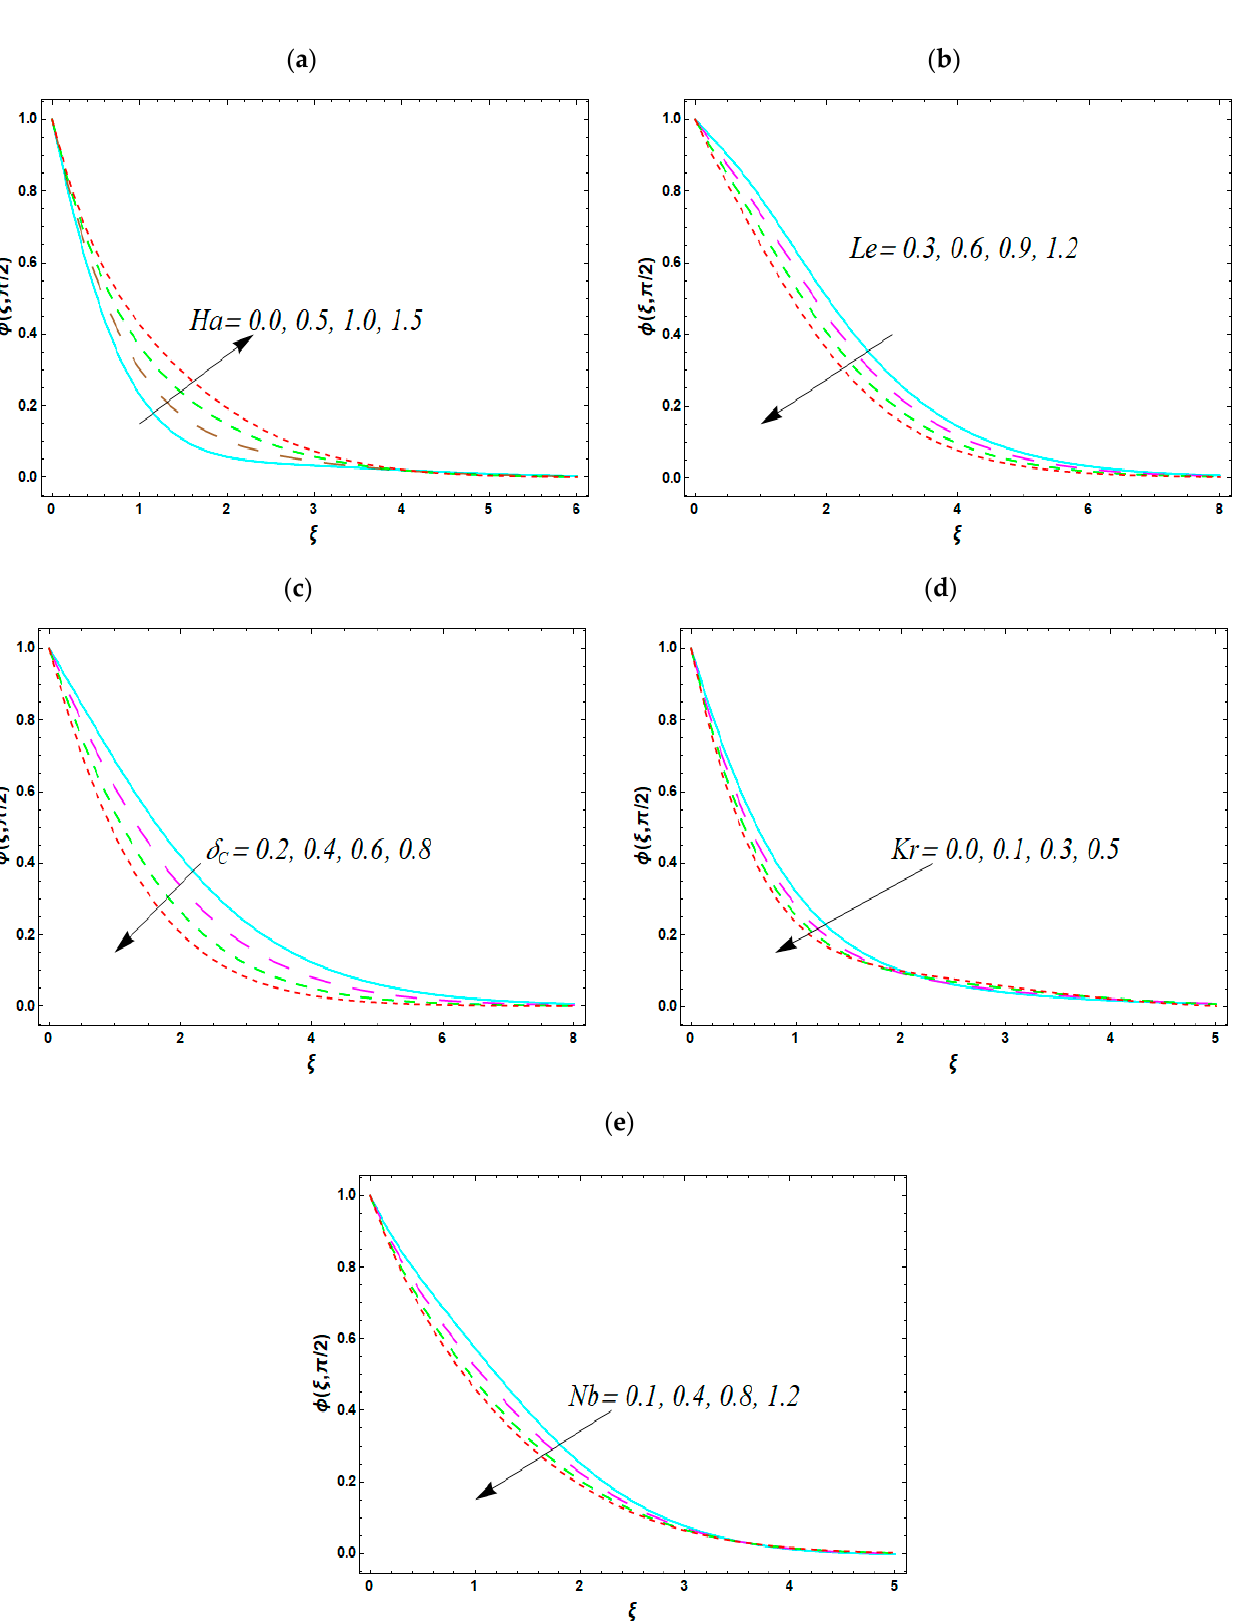
Figure 6. Concentration profiles for various values of ( a ) Ha , ( b ) Le , ( c ) δ C , ( d ) Kr and ( e ) Nb